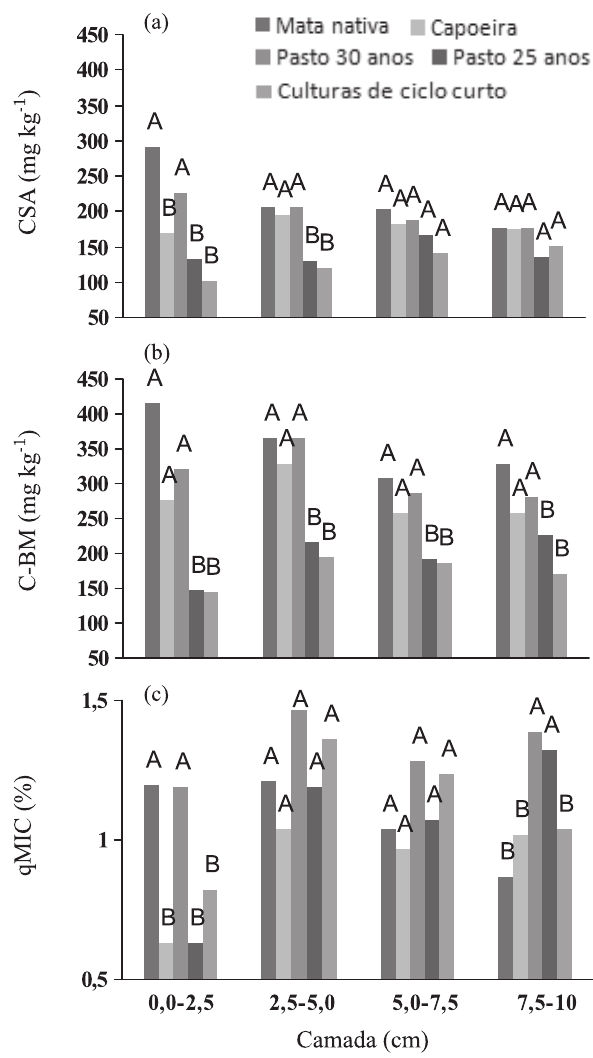
Figura 1. Valores de C orgânico solúvel em água (Csa) (a), carbono da biomassa microbiana (C- bm) (b) e quociente microbiano (qmiC) (c) em Latossolo amarelo húmico estudado. médias seguidas de mesma letra, entre os diferentes usos e dentro de cada camada, não diferem estatisticamente entre si pelo teste de scott- Knott a 5